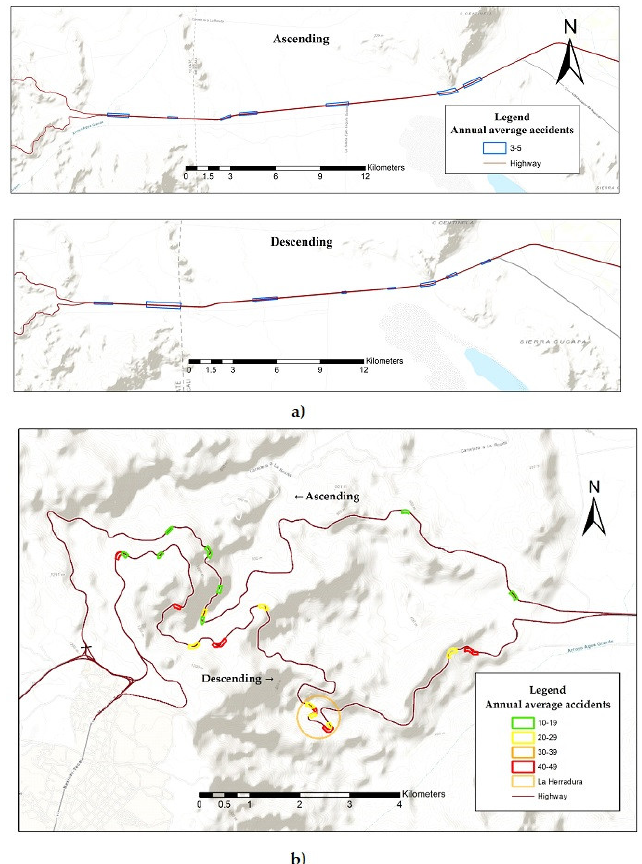
Figure 4. Critical zones of annual average accidents in the highway 2000–2018: ( a ) annual average in the flat zone; ( b ) annual average in mountain